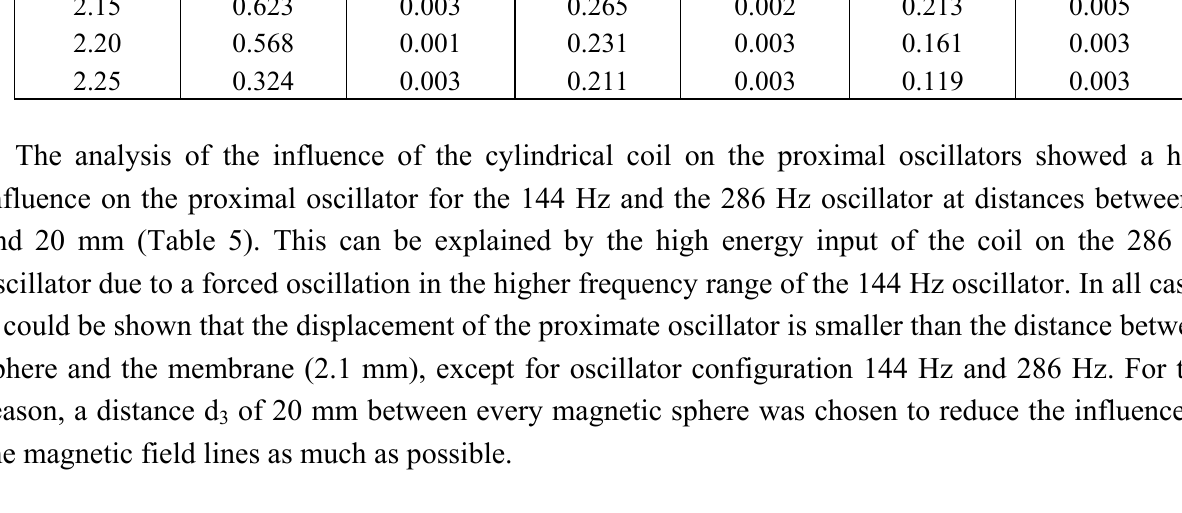
of the influenced oscillator 2 3